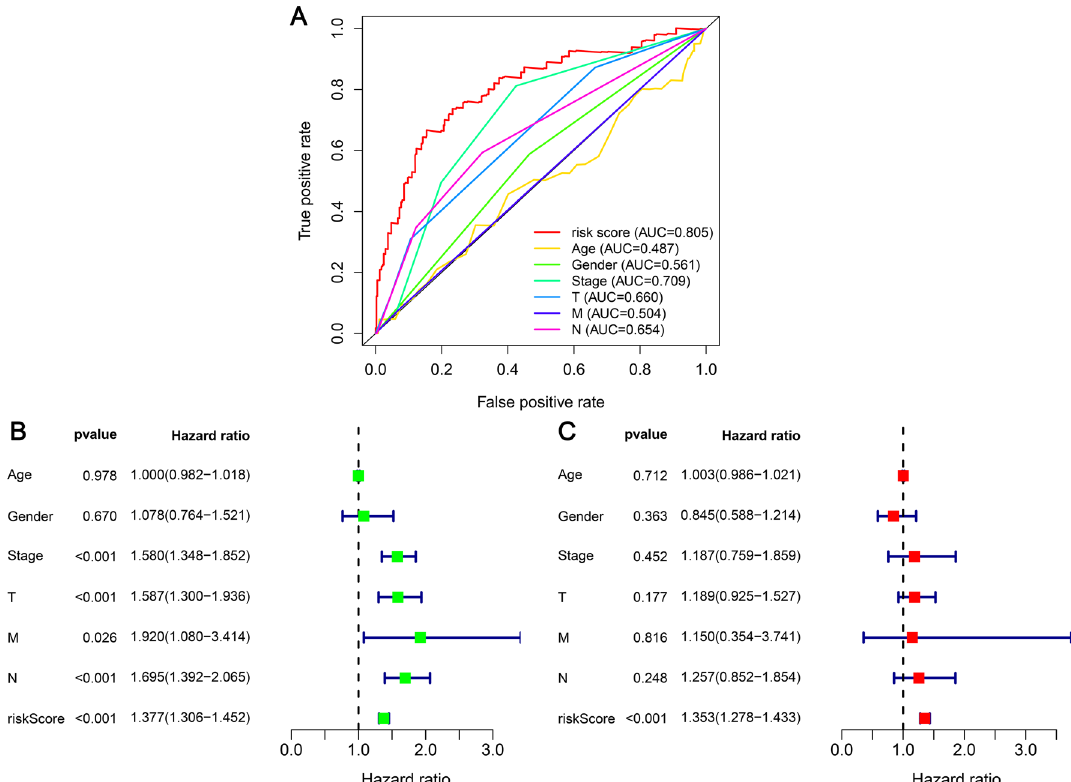
Figure 6. Cox regression analysis of clinically relevant characteristics and integrated ROC curves. ( A ) Riskscore (AUC = 0.805) and Stage (AUC = 0.709) had the greatest predictive performance. ( B ) Univariate Cox hazard ratio analysis demonstrated that Stage, T stage, N stage, and risk score were statistically different (p < 0.001). ( C ) Multivariate Cox analysis depicted the riskscore as the only independent predictor of prognosis (p < 0.001).